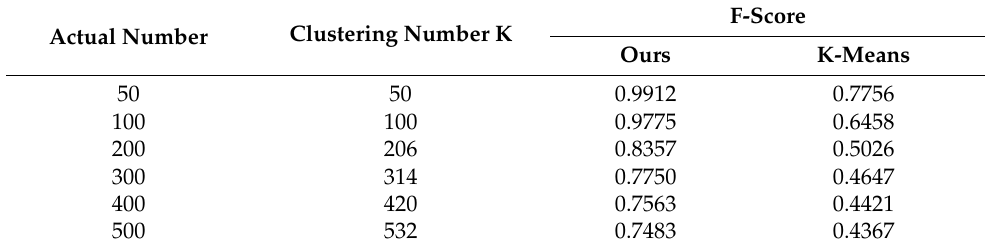
Table 3. Clustering test results for the CFP Face Database.